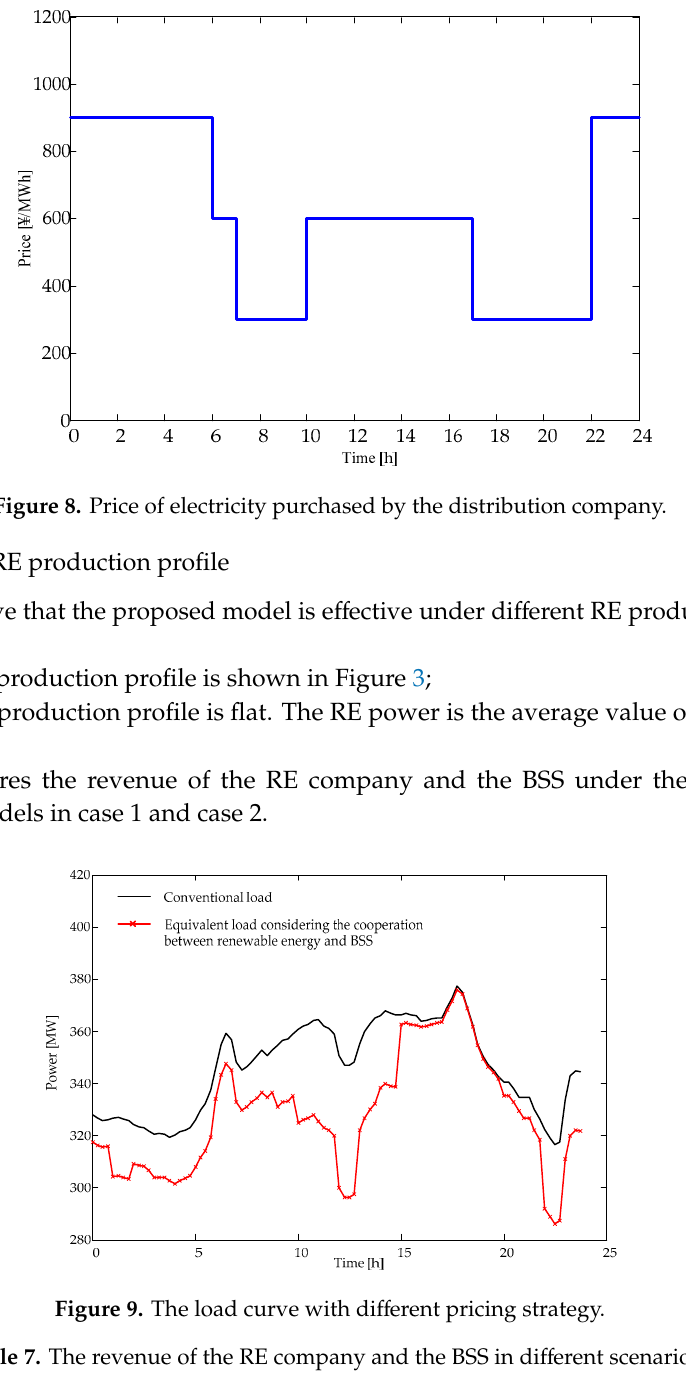
14 of 18 Figure 7. The load curve under different conditions. •